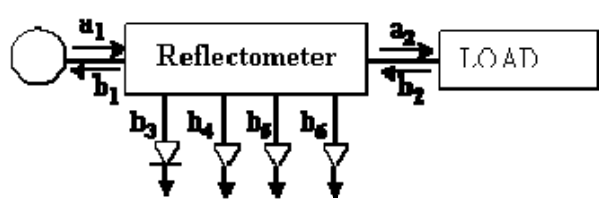
Figure 1. Six-port reflectometer